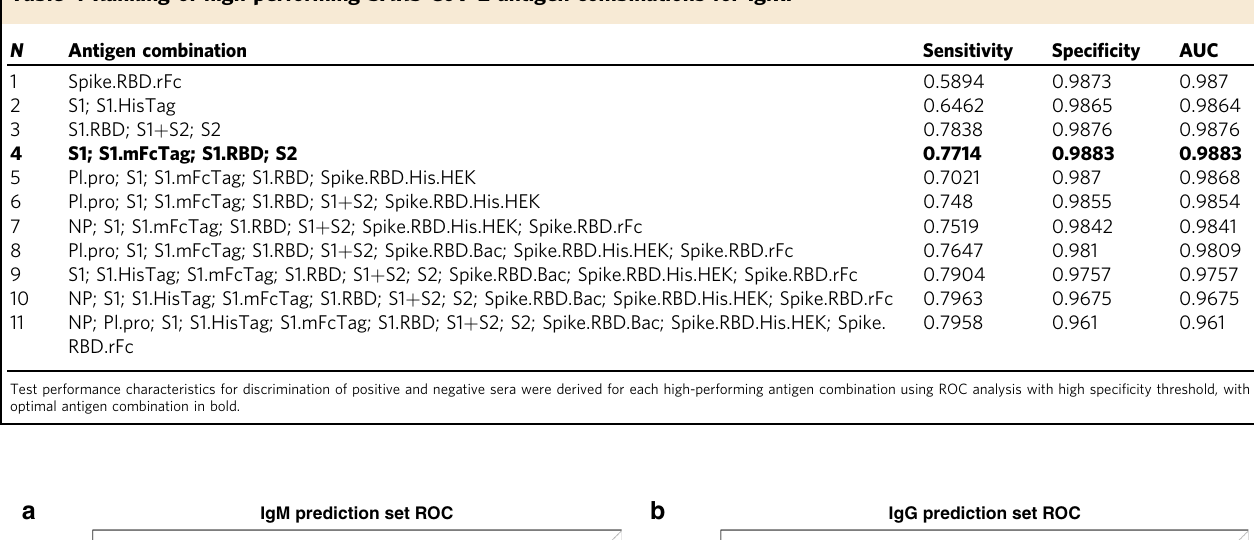
Table 4 Ranking of high-performing SARS-CoV-2 antigen combinations for IgM.